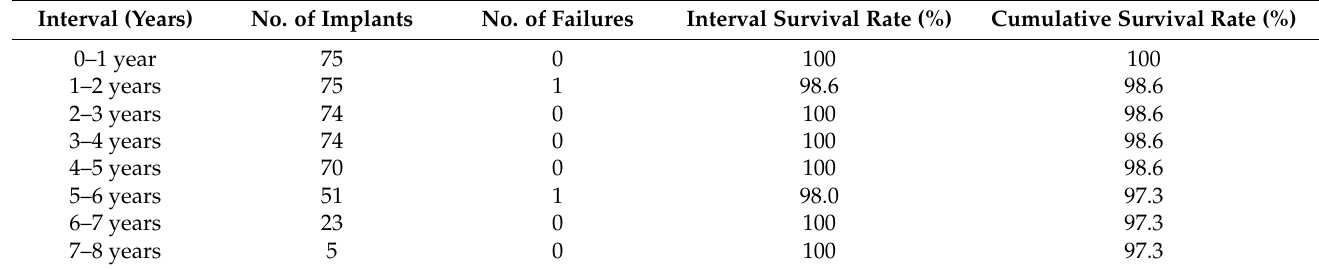
Figure 1. Patient with a fractured upper first pre-molar four years post-cementation. Three years prior, the same patient experienced fracture in an upper second pre-molar, which was replaced with a screw-retained implant restoration. Table 4. Life table analysis on implant survival level in the bruxer group.